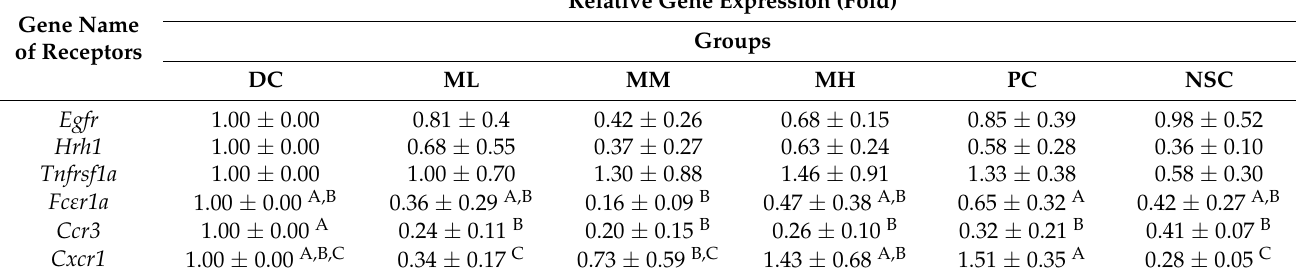
Table 8. Effects of menthone inhalation with different doses on gene relative expression levels of receptors related to allergic inflammation in the mouse lungs of OVA/Al-sensitized and challenged BALB/c asthmatic